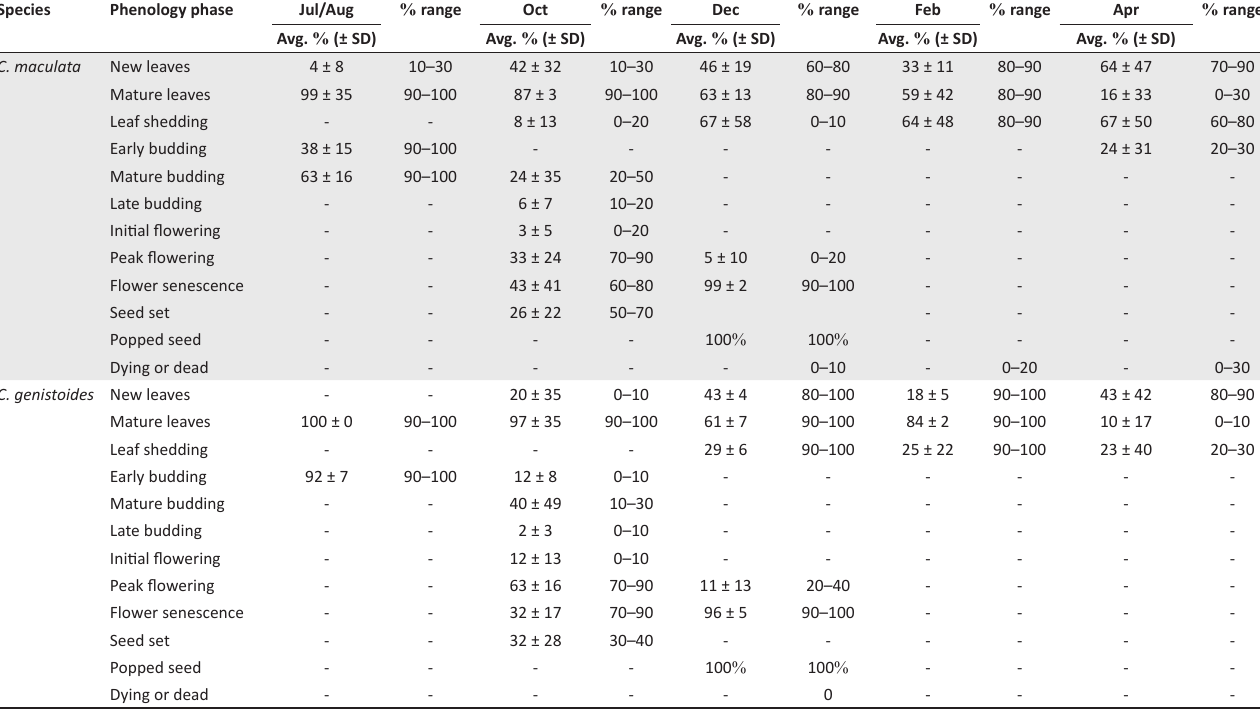
TABLE 1-A1: Phenology of two honeybush species (wild Cyclopia maculata [ n = 240] and cultivated Cyclopia genistoides [ n = 180]), representing reseeder and resprouter fire-survival strategies,